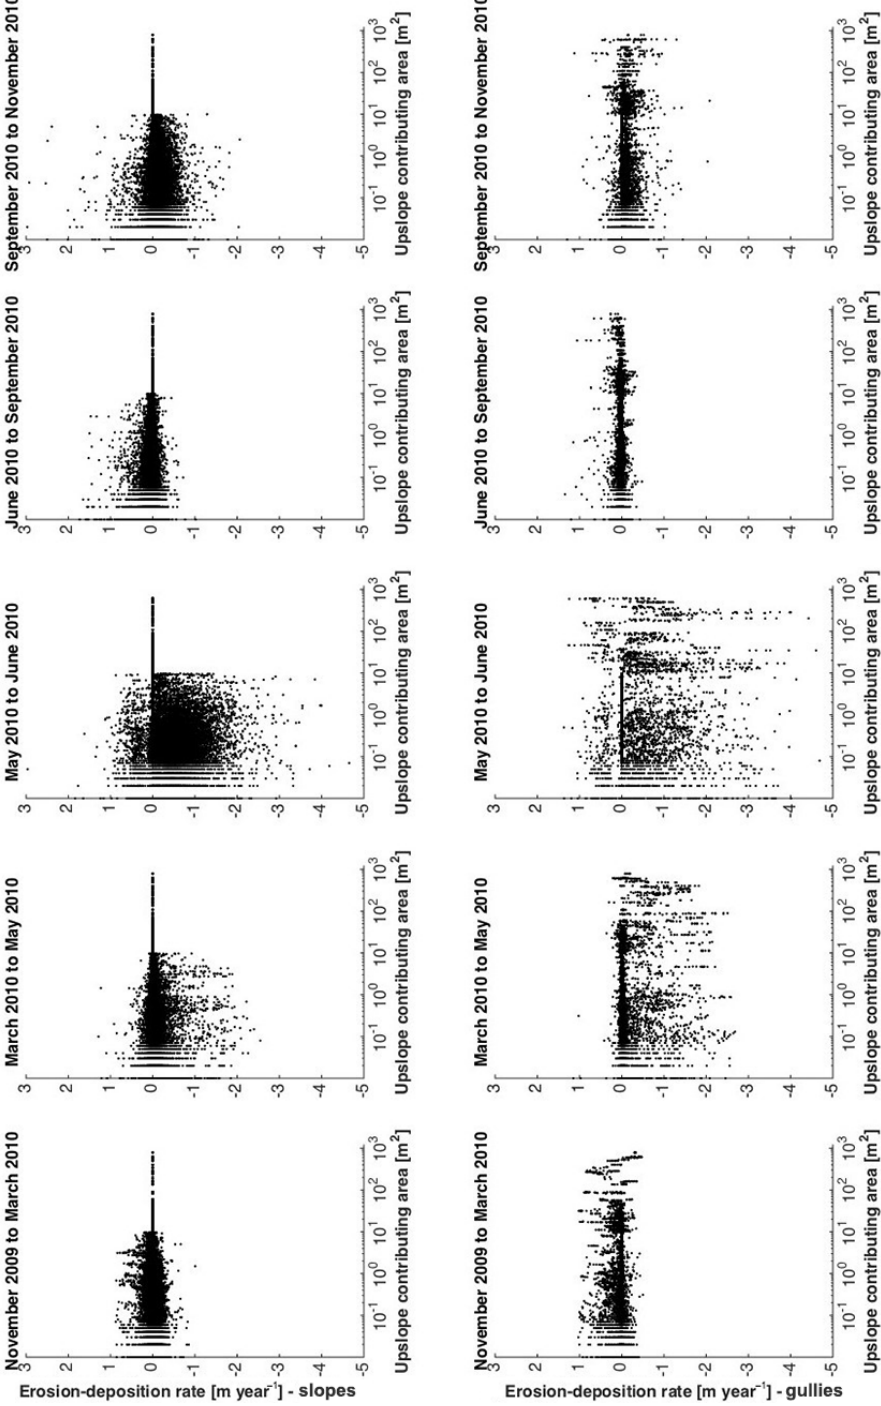
Figure 6. Vertical change over time vs. upslope contributing area. Rates are calculated from a 10cm grid average of original DoDs and divided by the time separating the two lidar acquisitions. Upslope contributing area in square metres, calculated in ArcGIS on a 10cm DEM of June 2010. Top graphs of the left column show rates for slopes and the right column for gullies and adjacent (20cm or closer) pixels (see the Supplement for similar graphs showing vertical change in absolute value vs. contributing